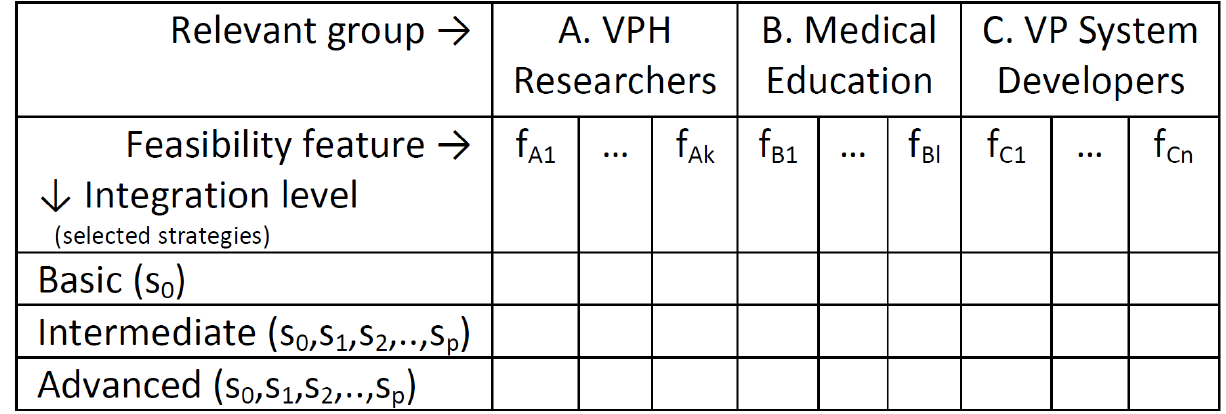
Figure 3. Method for systematic evaluation of different levels of simulation outcome integration.